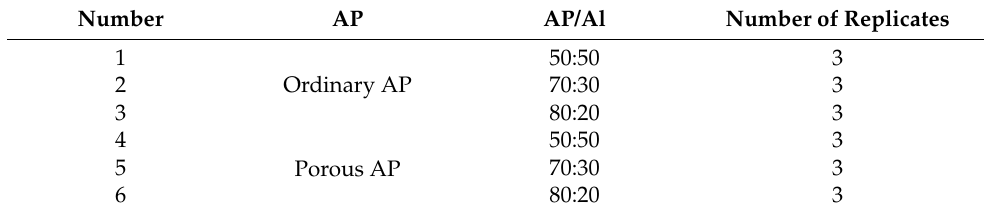
Figure 10. P–t curve for different AP:Al proportions. Table 3. The test scheme for the closed bomb.